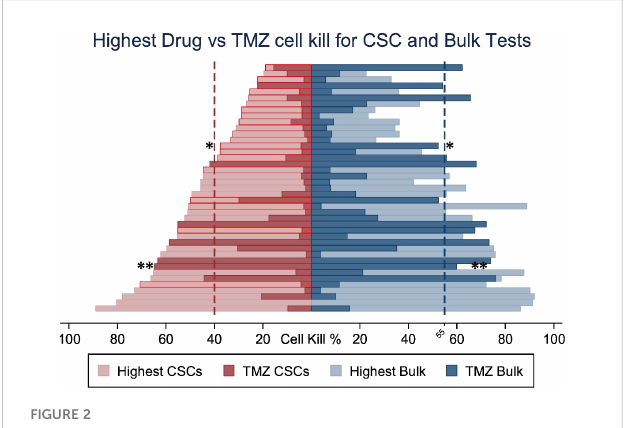
FIGURE 2 Percent cell death for the most cytotoxic drug and TMZ for each patient comparing Cancer Stem cell (CSC) vs bulk of tumour cell sensitivity to TMZ. Optimal therapies with highest cell death shown in light colours and cell detah by TMZ in dark. CSC results outlined in red show patients whose optimal therapy differs from the optimal therapy identi fi ed by the bulk of tumour cells test * p <0.05, ** p < 0.01. Adapted from Howard C.M., et al., 2017